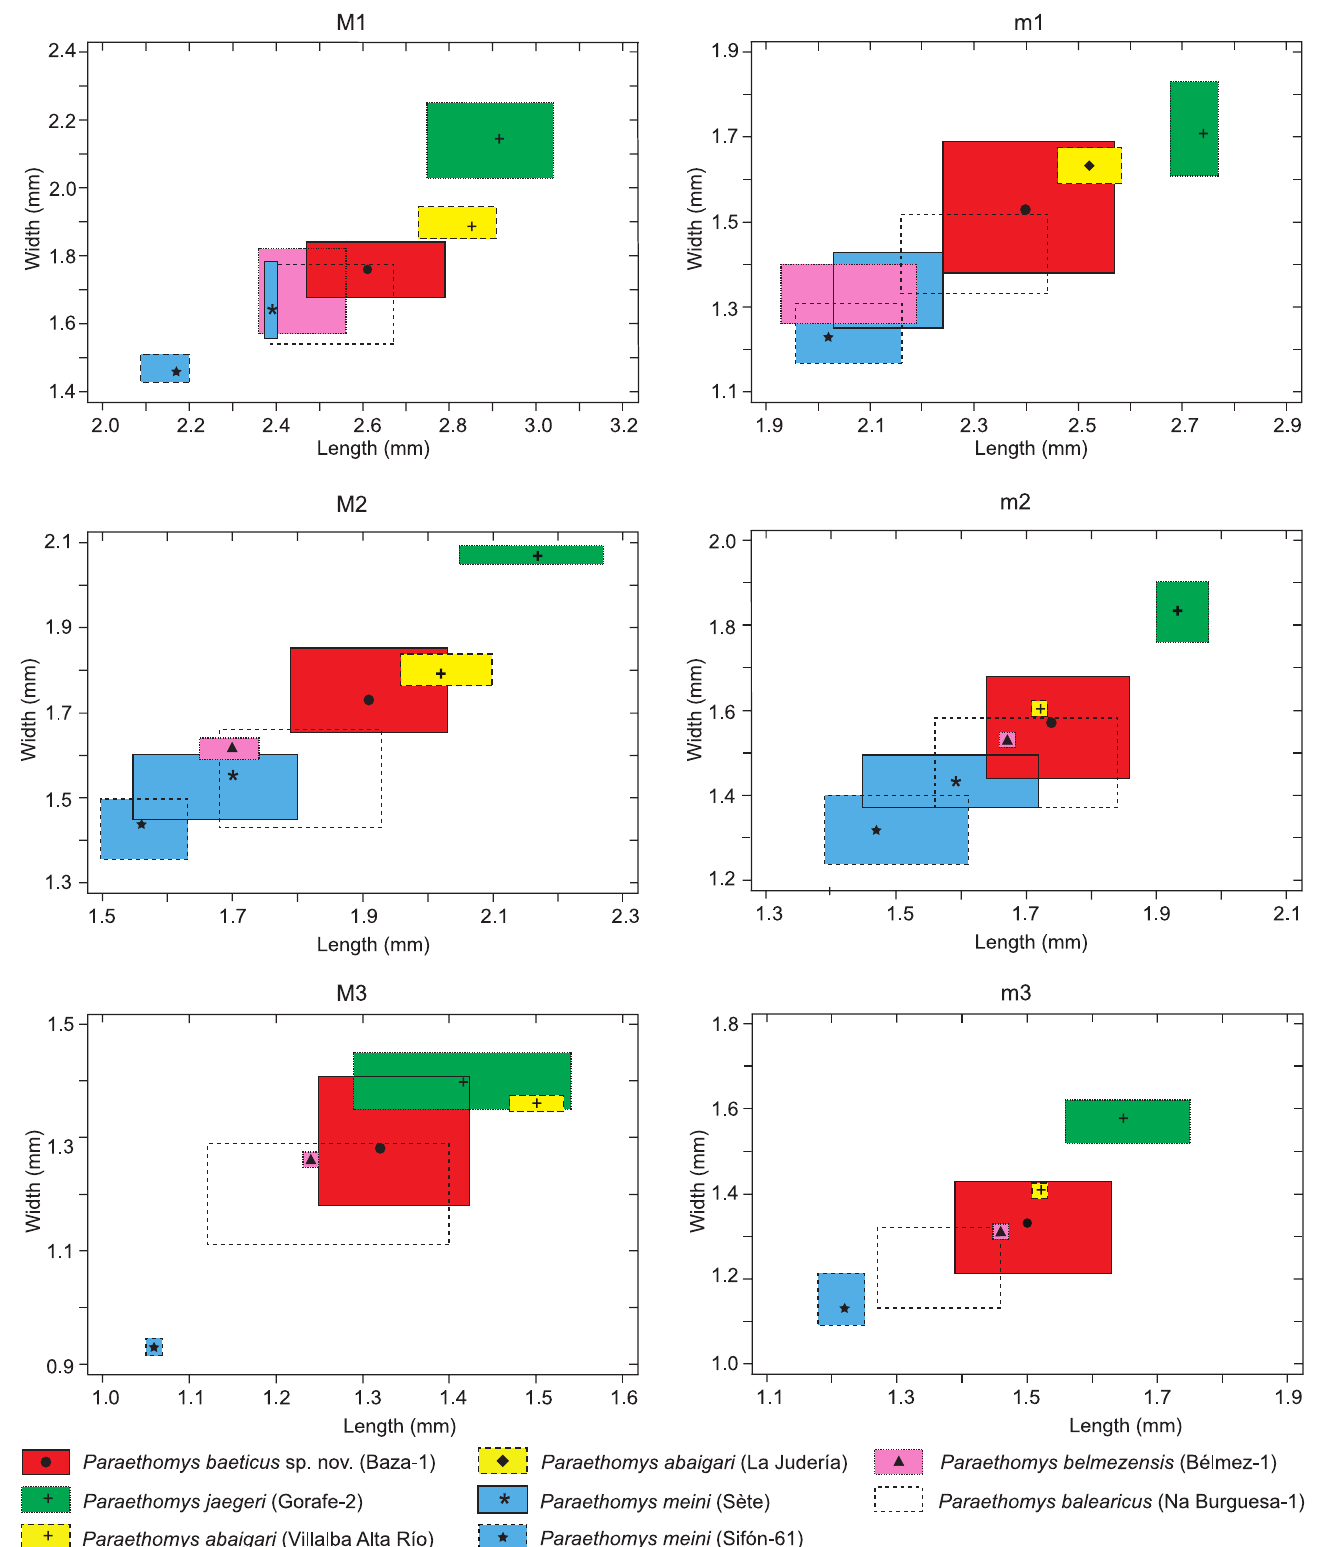
Fig. 4. Ranges of size variation (in mm) in the upper (M1–M3) and lower (m1–m3) teeth of Paraethomys baeticus sp. nov. from Baza-1 (type locality; this paper), Paraethomys jaegeri from Gorafe-2 (type locality; Montenat and De Bruijn 1976), Paraethomys abaigari from Villalba Alta Río (type locality) and La Judería (Adrover et al. 1988), Paraethomys meini from Sète (type locality; Michaux 1969; Adrover 1986) and Sifón-61 (Piñero and Agustí 2019), Paraethomys belmezensis from Bélmez-1 (type locality; Castillo Ruiz 1992), and Paraethomys balearicus from Na Burguesa-1 (type locality; Torres- Roig et al. 2019). Mean sizes are marked by symbols inside the